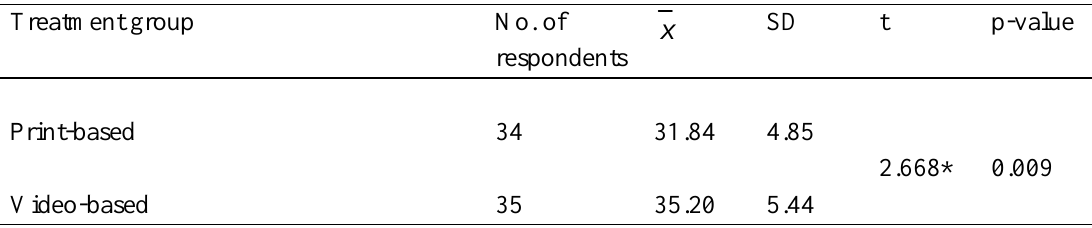
x SD t p-value respondents 2.668* 0.009